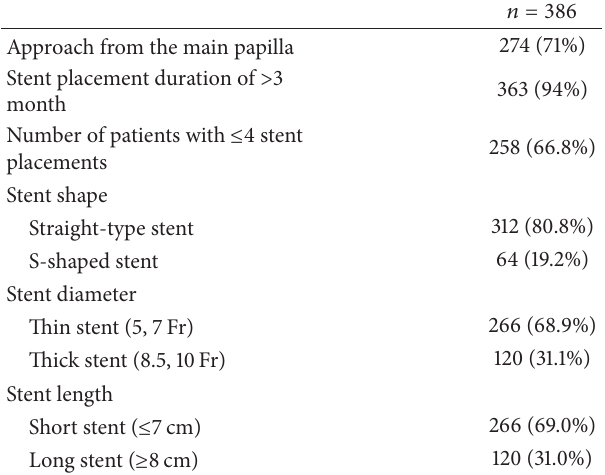
Table 2: Demographic characteristics of the stent